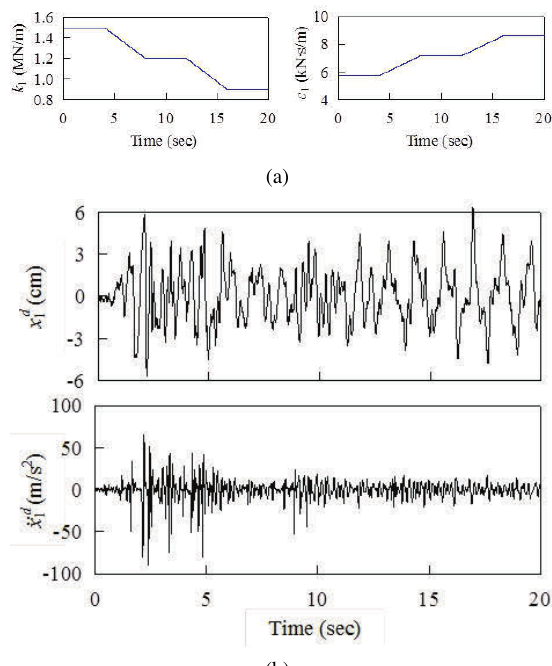
Figure 5. (a) Time-varying structural parameters and (b) measured responses of the damaged structure with 5% RMS